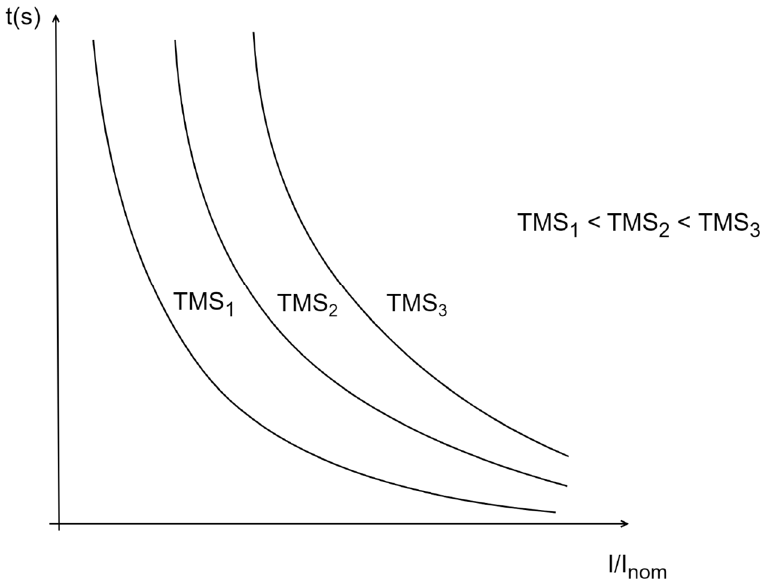
Figure 4. Different values of the Time Multiplier Setting (TMS) of an inverse time–current characteristic of an OCR.